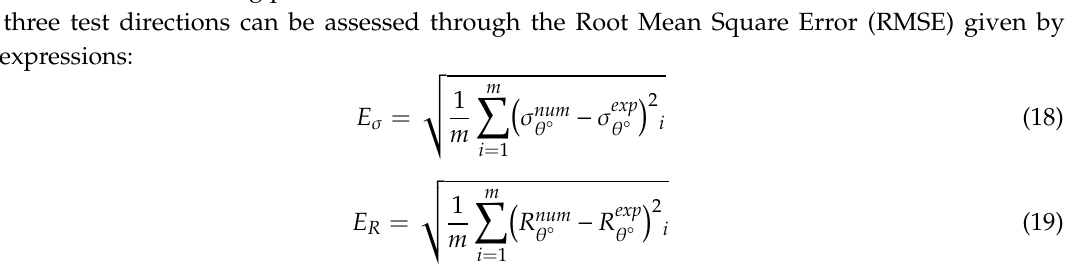
Table 5. RMSE of the fitting procedure in the true stress-strain curves and Lankford coefficients.